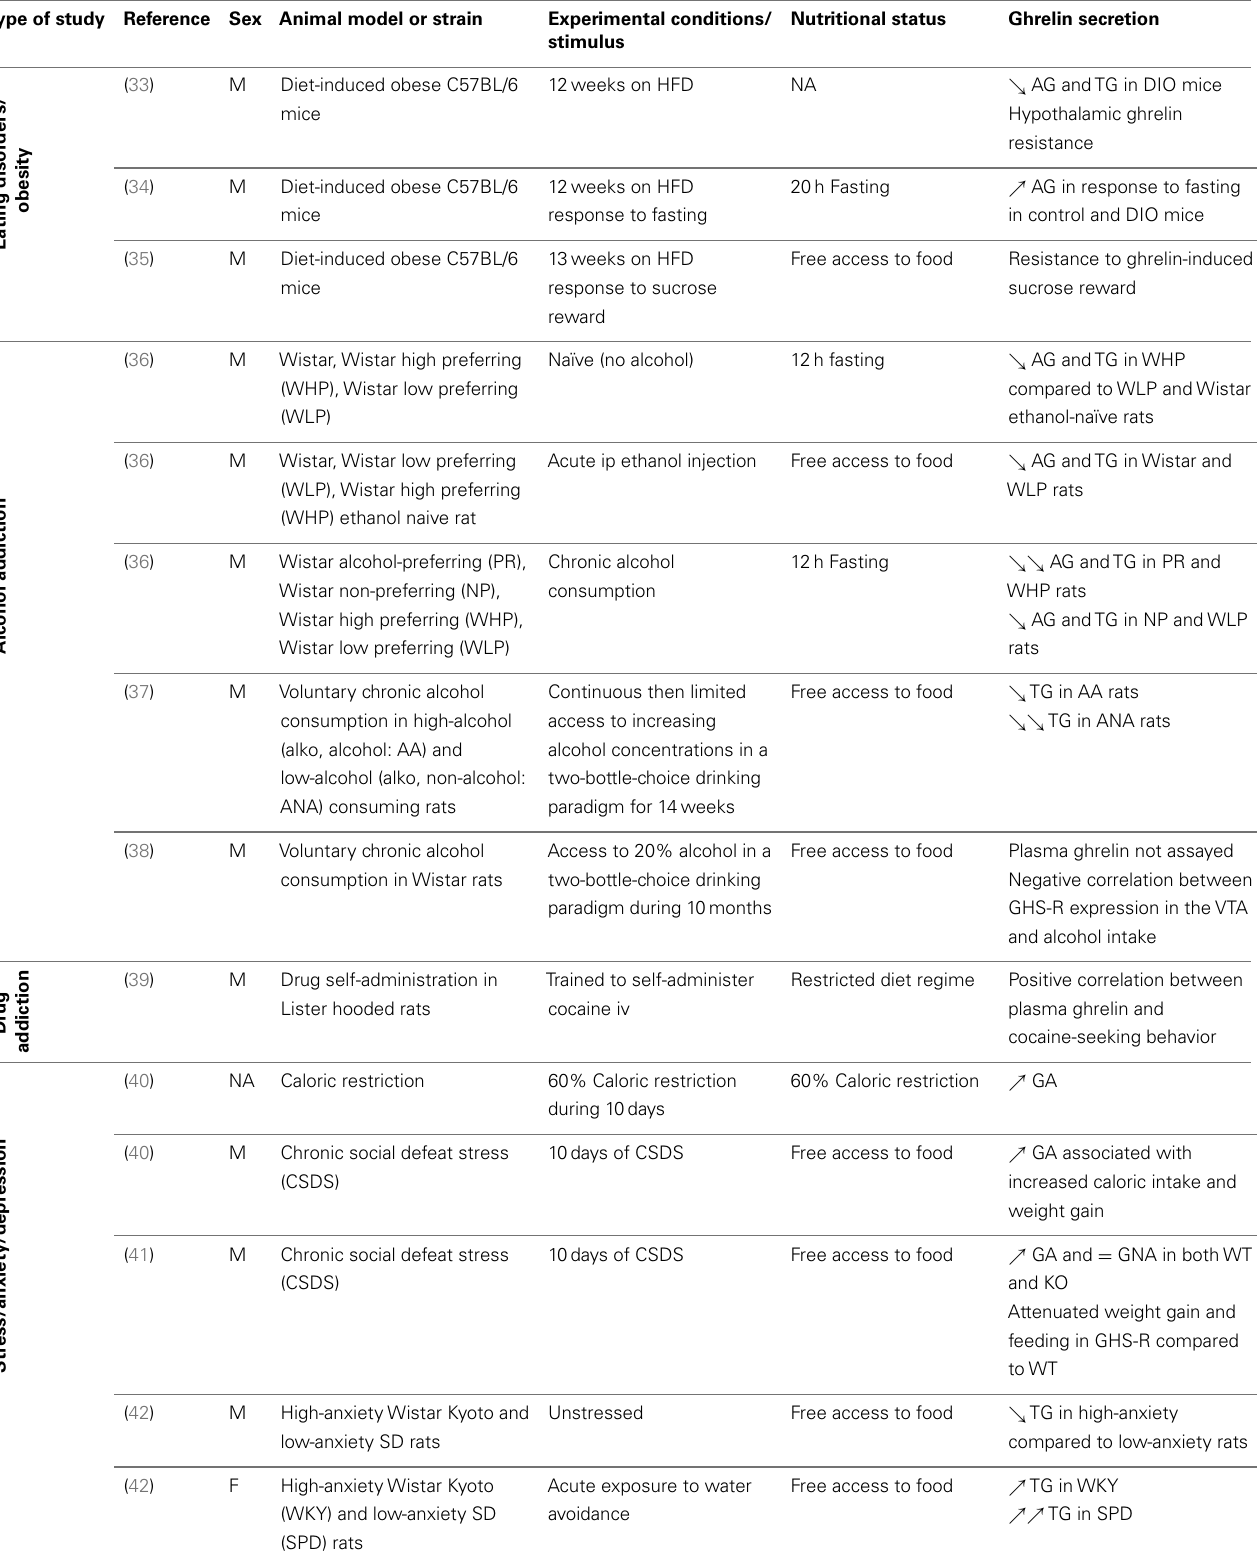
Table 1 | Regulation of plasma ghrelin concentrations in different mouse models, nutritional status, and experimental conditions . Type of study Reference Sex Animal model or